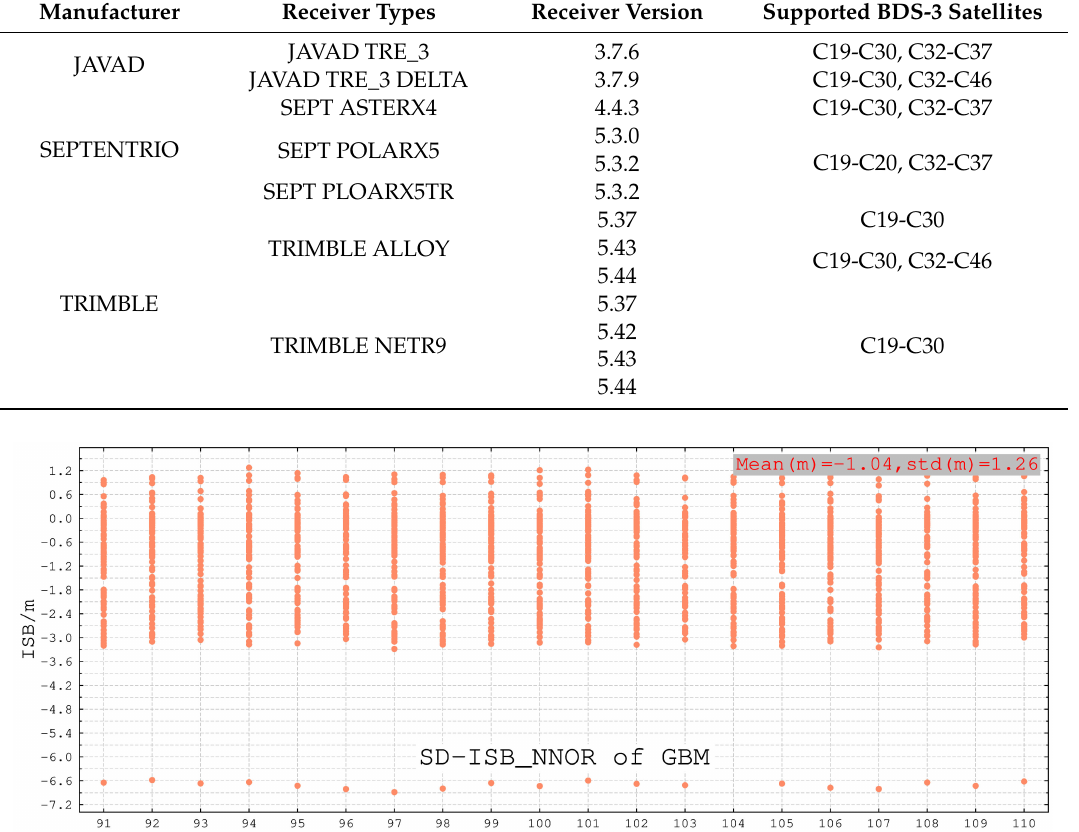
Figure 7. The distribution of the 85 MGEX stations. Table 2. Receiver information of the selected MGEX stations.